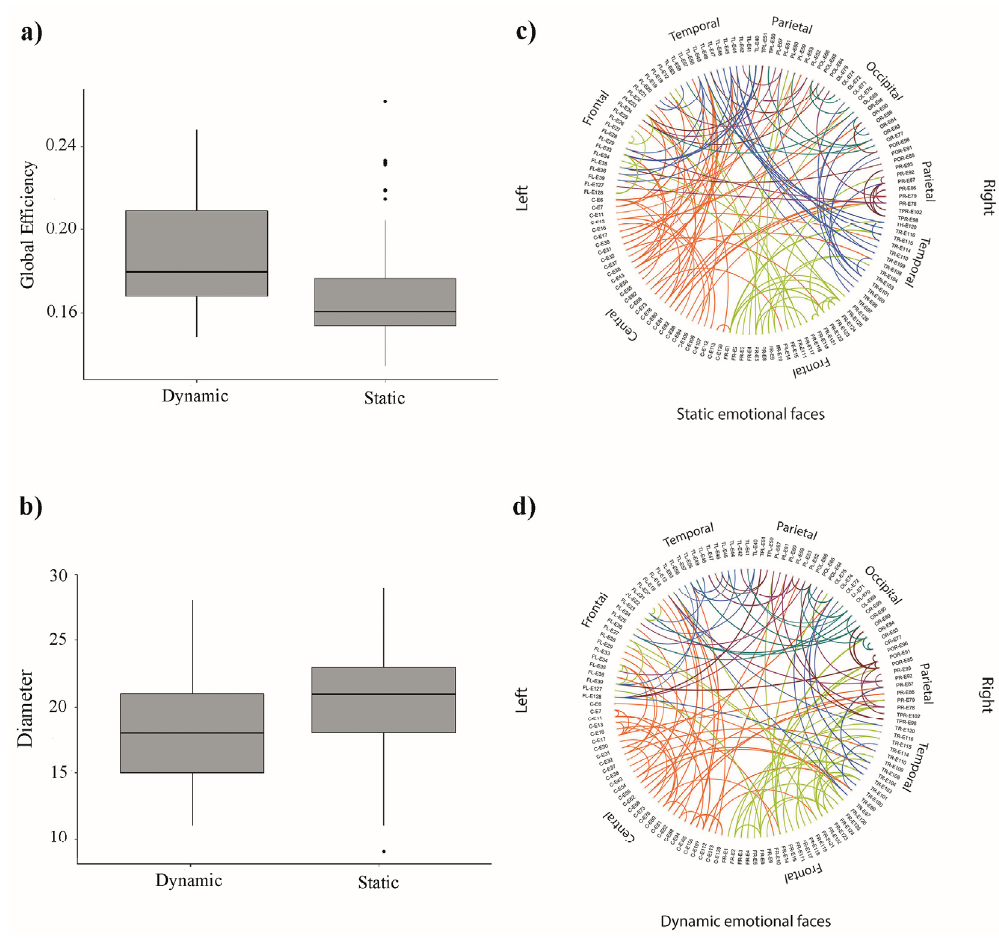
Figure 3. Illustrations of the functional connectivity results. The left panels show box plots depicting the difference in global efficiency ( a ) and diameter ( b ) between the dynamic and static conditions. The right panels depict circular graphs representing the topological organization of MSTs in the static ( c ) and dynamic ( d ) conditions.